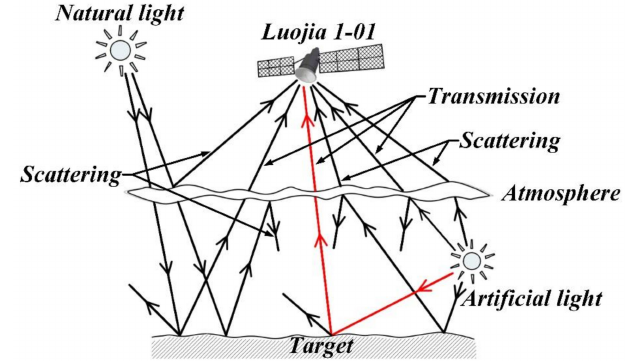
Figure 3. Radiative transfer process of night-light remote